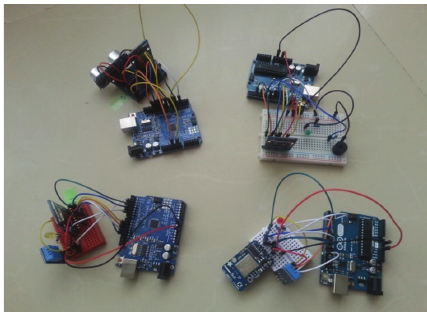
Figure 5: Four Arduino boards connected with Adafruit CC3000 boards as well as sensors and actuators representing UAV payload systems and their resources.